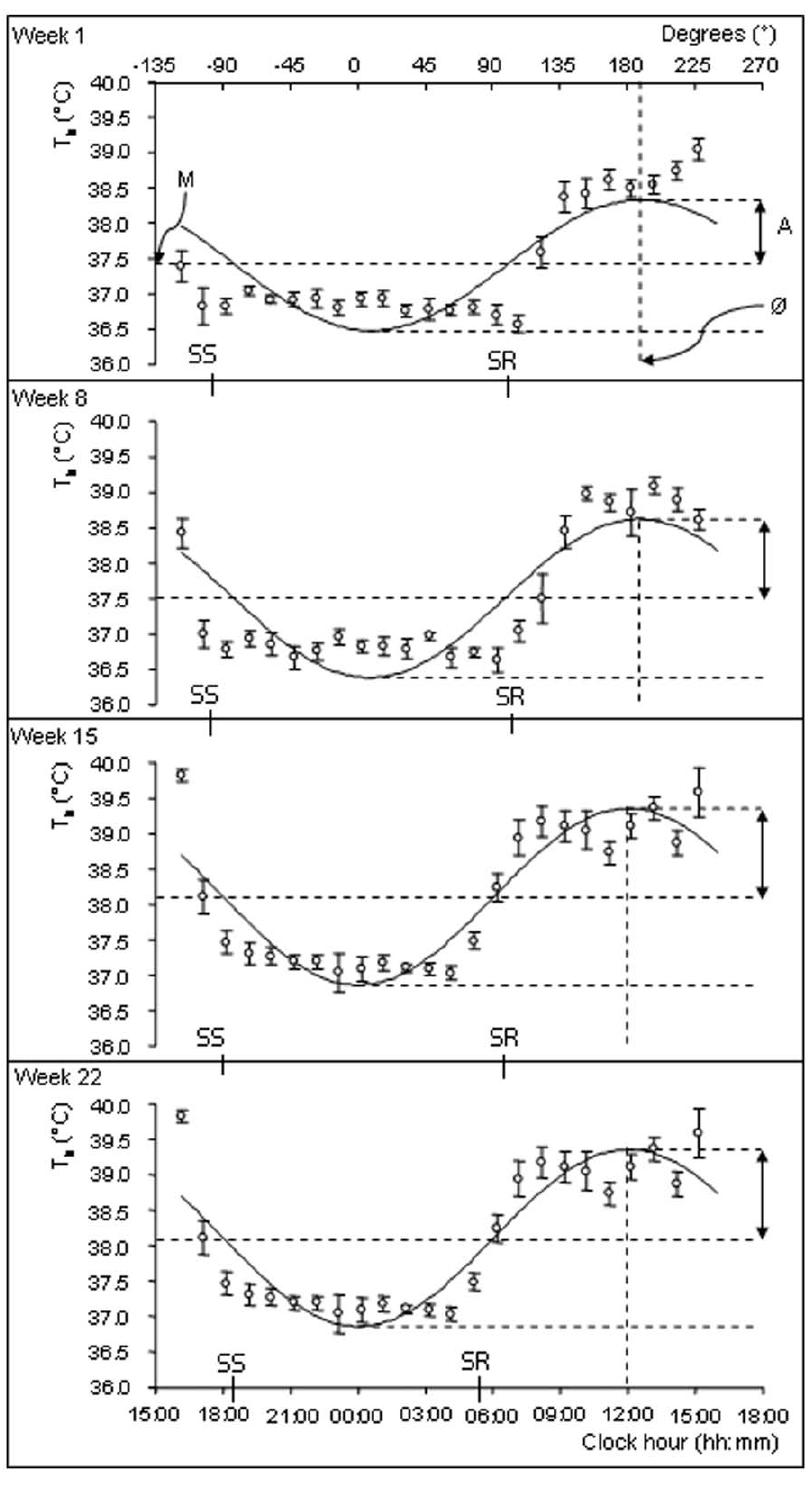
Figure 1. Body temperature (T b ) daily rhythm of an adult Cape ground squirrel (605 g) for the first (21 to 28 May), eighth (09 to 16 July), fifteenth (27 August to 03 September) and twenty-second week (15 to 22 October) of a 23-week measurement period. ‘M’ indicates the mesor (37.41 u C), ‘A’ the amplitude (0.92 u C) and ‘Ø’ the acrophase (189.11 u or 12:36 h) of the fitted cosine curve. SR and SS show times of sunrise and sunset.